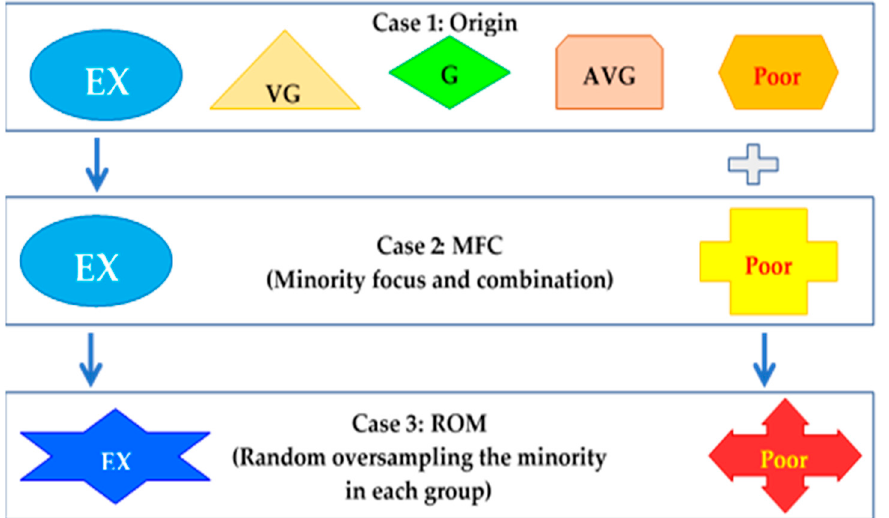
Figure 3. Class distribution in three cases. Note: EX = class “Excellent”, VG = class “Very good”, G = class “Good”, AVG = class “Average”.